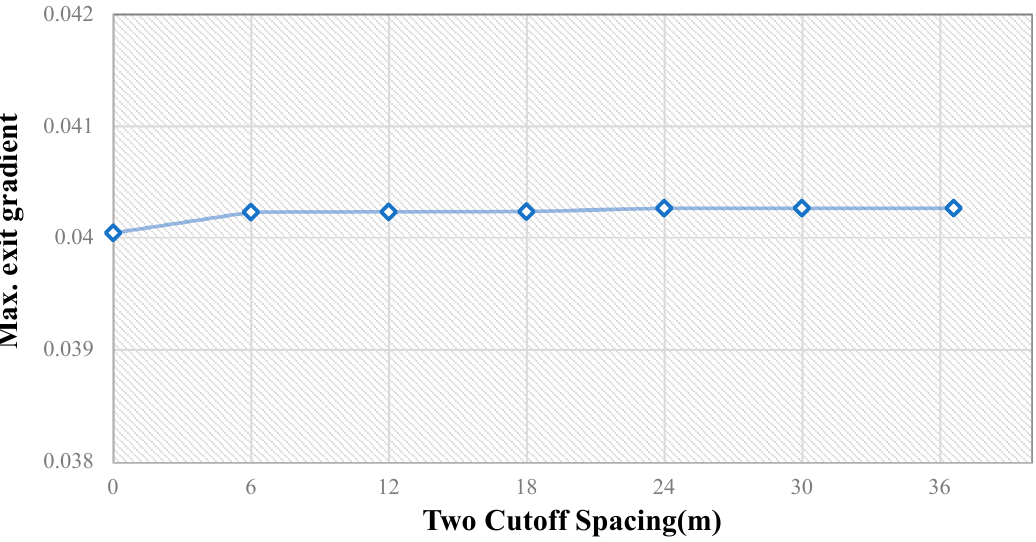
Figure 14. Maximum gradient of outlet discharge under the core for different cutoff spacing.